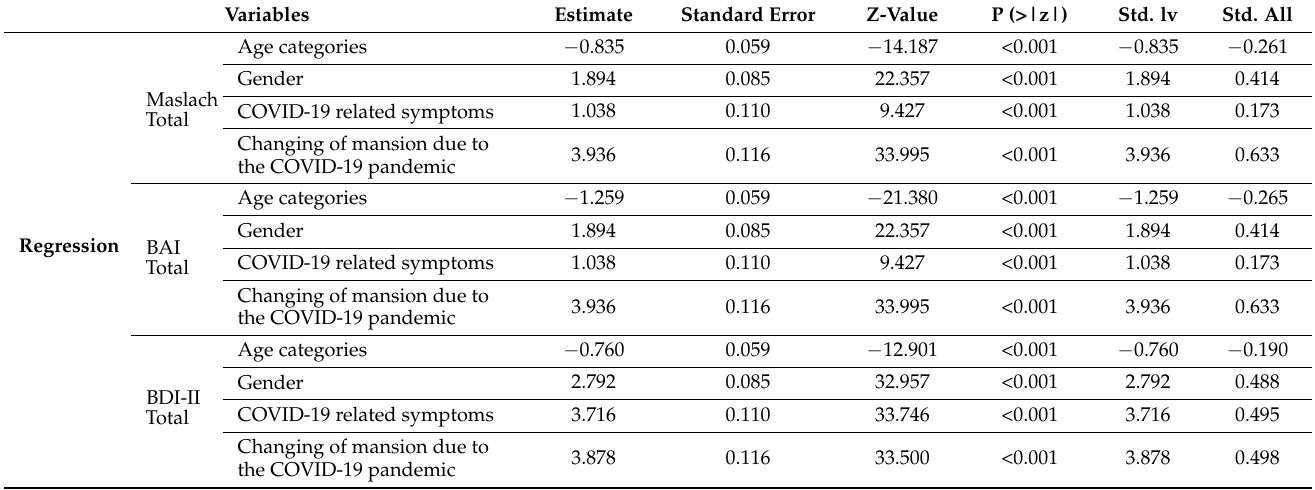
Figure 5. Mediation analysis with covariances (Age categories, Gender, COVID-19 related symptoms, Changing of mansion due to the COVID-19 pandemic). Legend: Correlations among Emotional Exhaustion (EE), Depersonalization (DP), Personal Accomplishment (PA), Beck Depression Inventory (BDI-II), Beck Anxiety Inventory (BAI), Impact of Event Scale (IES) and General Health Questionnaire 12 Items (GHQ-12). QoL = Impact of COVID-19 pandemic on Quality of Life (QoL). Table 4. Regression, covariance, intercept, and variance of Maslach Burnout Inventory—Human Services Survey for Medical Personnel (MBI-HSS MP), Beck Depression Inventory (BDI), Beck Anxiety Inventory (BAI), Impact of Event Scale (IES) and General Health Questionnaire (GHQ). Variables P (>|z|) Std. lv Std.